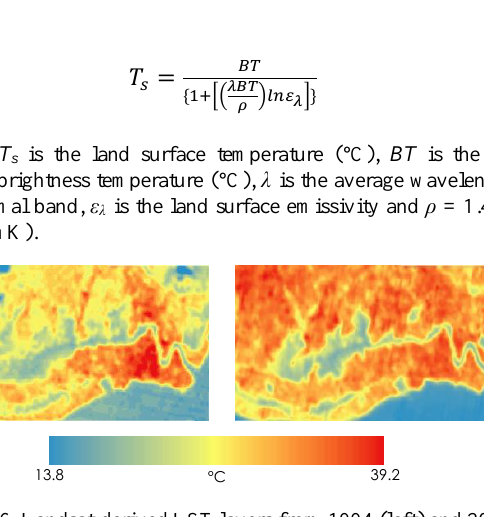
Figure 6. Landsat-derived LST layers from 1994 (left) and 2019 (right) satellite images